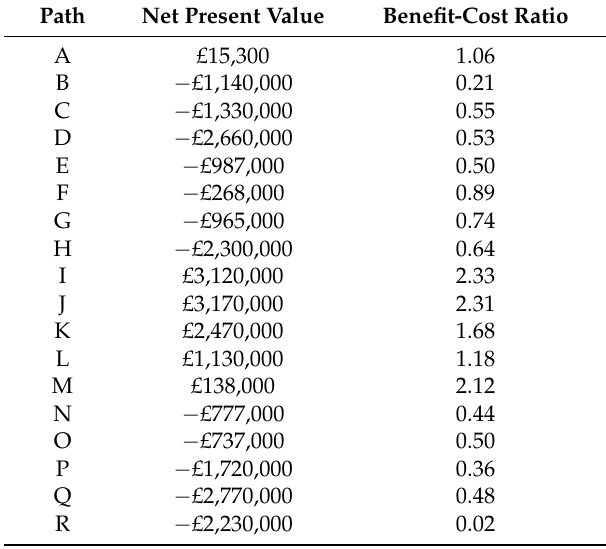
Table 4. Net Present Values and Benefit-Cost Ratios of the paths explored. Path Net Present